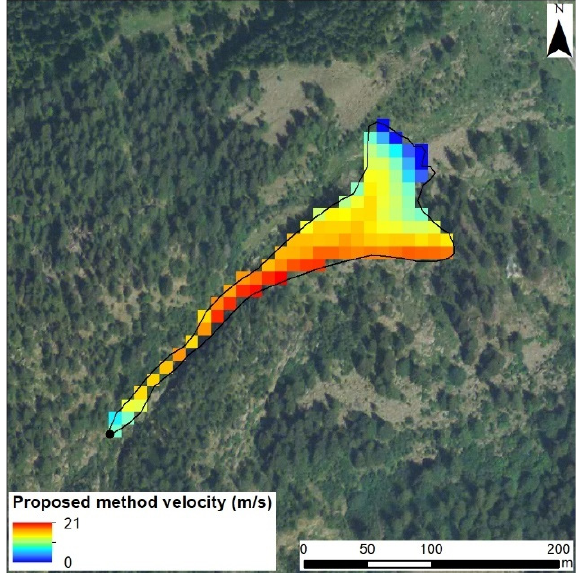
Figure 5. Velocity values of a shallow landslide obtained by a Matlab code based on the Heim method. The continuous black line corresponds to the landslide boundary, and the black point to the release reference point according to the IFFI inventory.